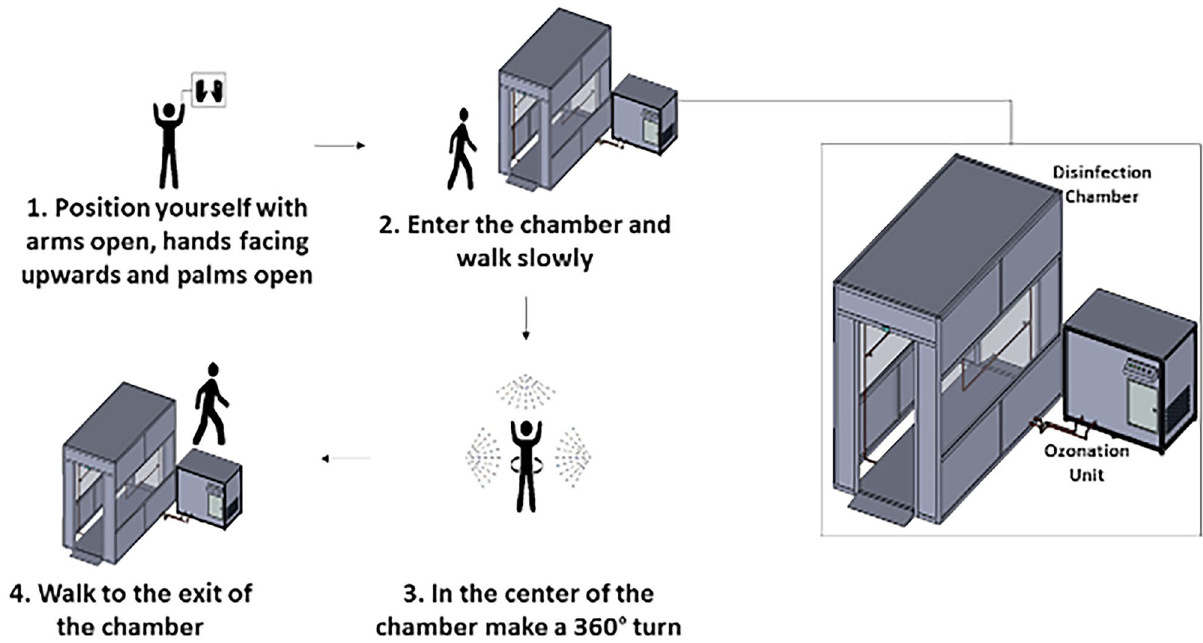
Figure 3. Instructions given to the participants for correct use of the disinfection